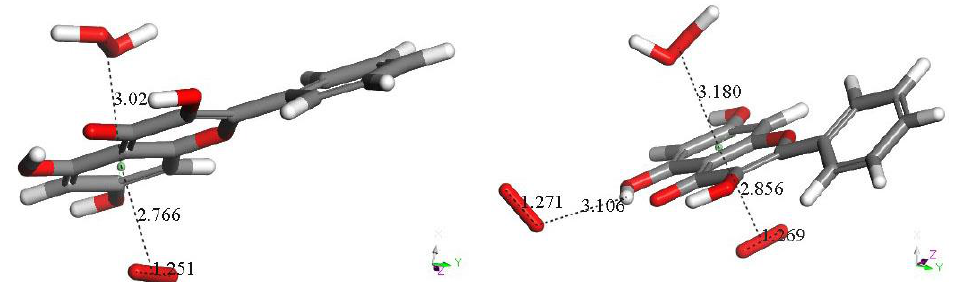
Figure 2. ( Left ) after excluding H 2 O 2 (red) from Scheme 2 (g), the remaining di-cation species is posed π - π to a superoxide radical, 3.50 Å. Its geometry optimizatio n shown here enables the super- oxide to be incorporated into the polyphenol system, with centroid-centroid separation, 2.766 Å , and keeping H 2 O 2 π - π bound to the ring, 3.024 Å. ( Right ) the cation shown on the left is van der Waals posed (2.60 Å ) by an additional superoxide nearing H(hydroxyl) in position 5. This σ ap- proaching superoxide evolves toward formation of O 2 (O-O bond = 1.271 Å ), detached from the remaining species (3.106 Å), which is a galangin complex comprising π - π bound H 2 O 2 and O 2 . 3.3. Butein